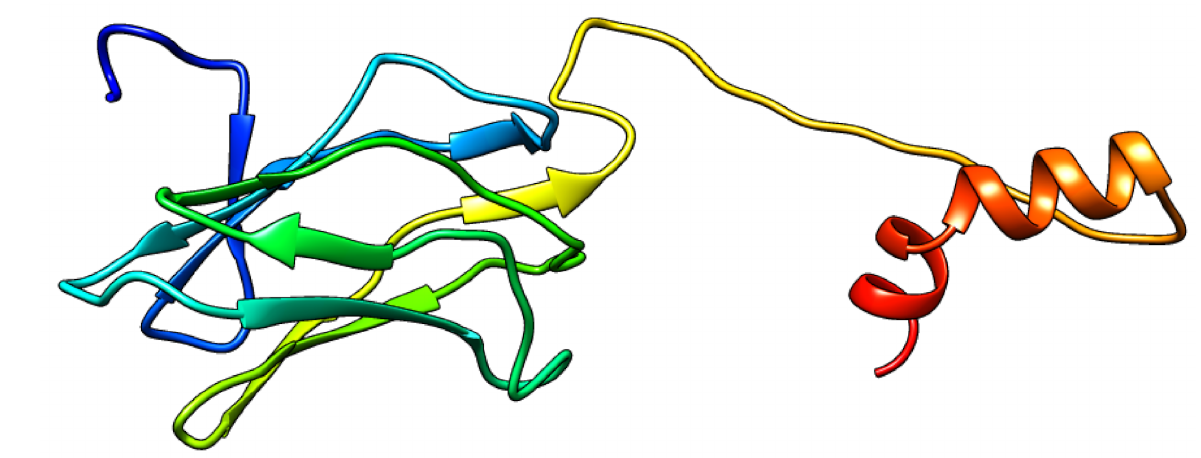
Figure 6. The three-dimensional structure of Runx2 using the SWISS-MODEL.